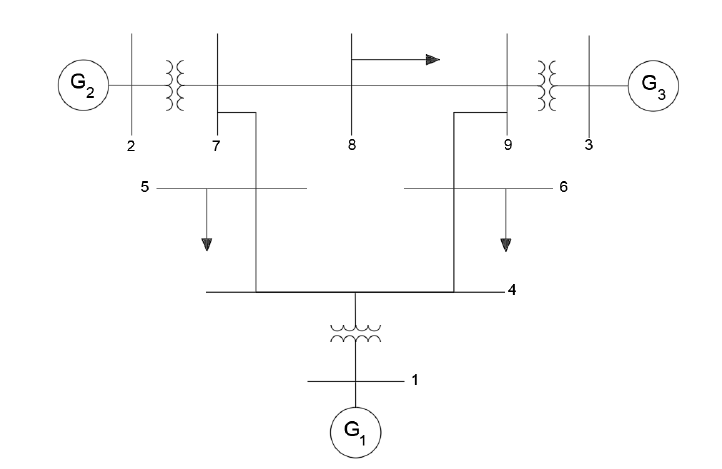
Figure 1. 3 Machine-9 bus